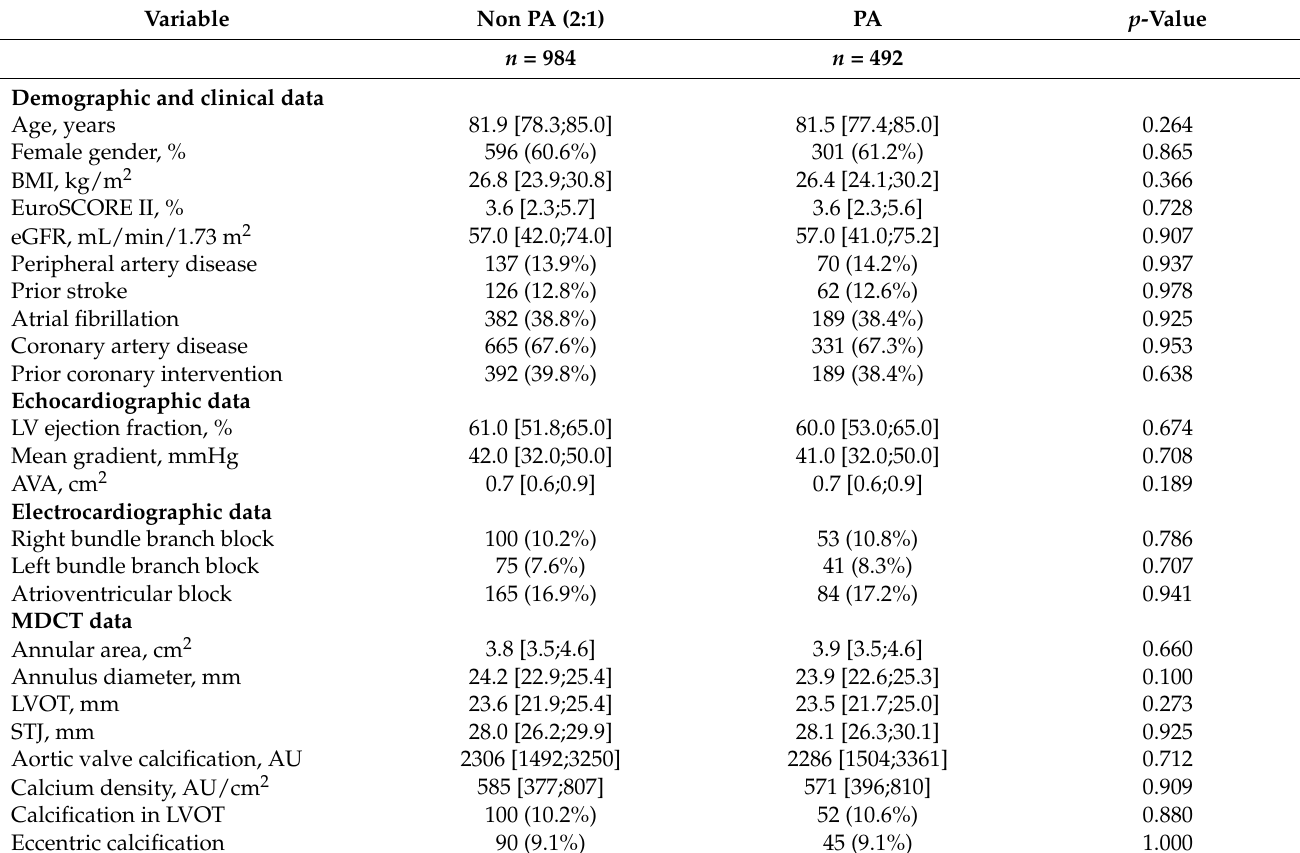
Table 2. Baseline characteristics for matched